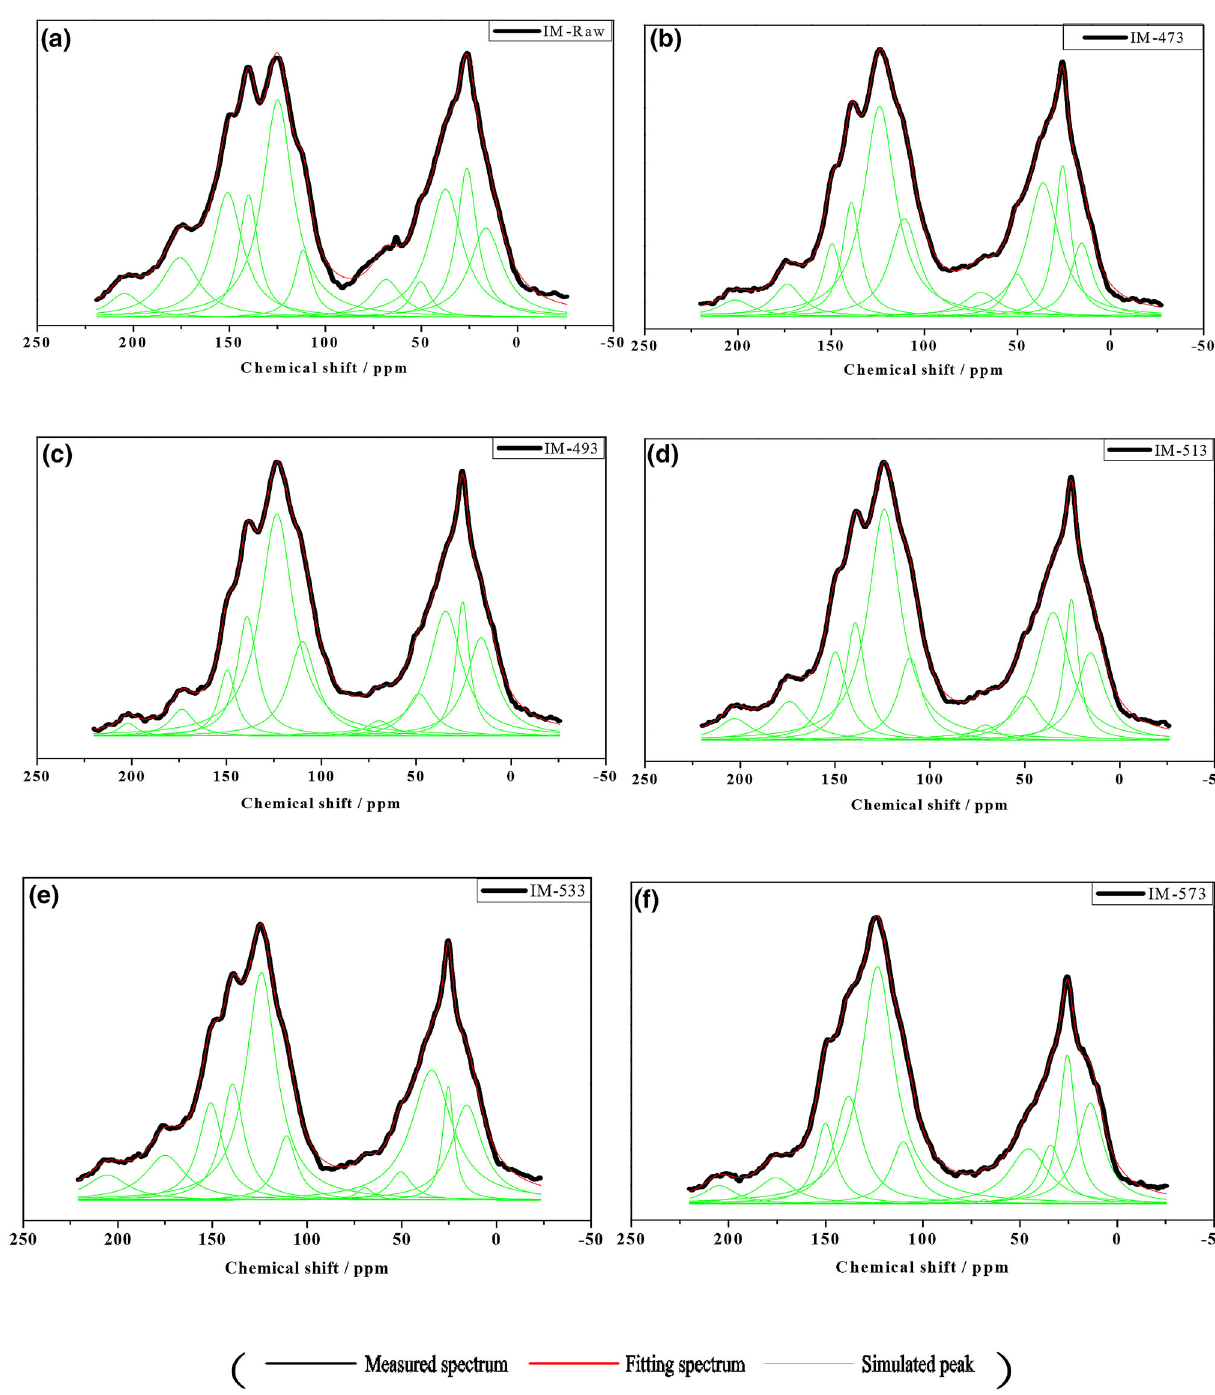
Fig. 4 Fitted 13 C NMR spectra of the raw and treated IM (Black line is measured spectrum, red line is fitting spectrum, green line is simulated